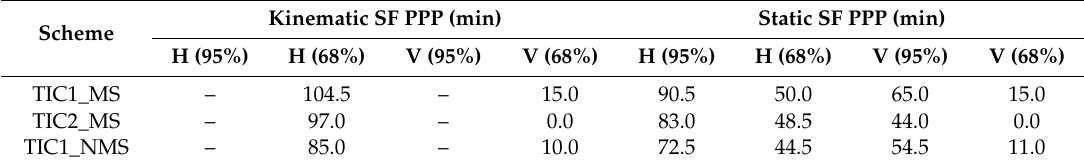
Table 4. The convergence times of GPS static and kinematic SF PPP in MS and NMS of TIC1 or TIC2.